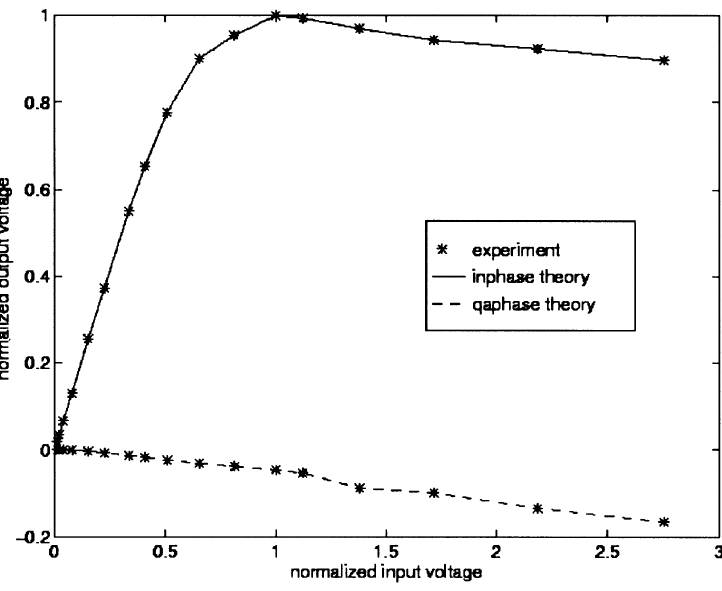
FIGURE 3 Quadrature model for single carrier measurements.